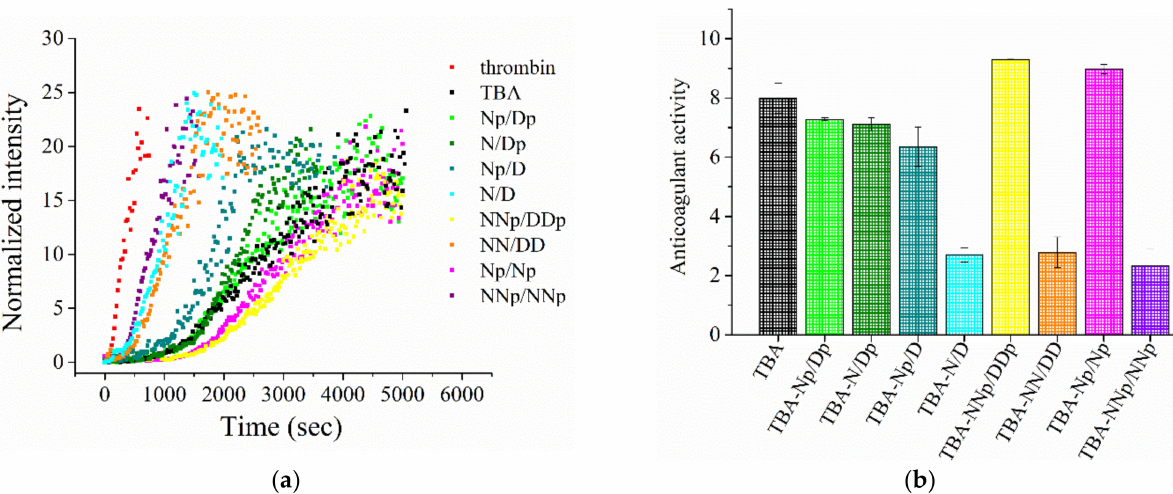
Figure 7. ( a ) Coagulation curves for the pseudo-cyclic TBAs and unmodified TBA at 1:5 thrombin:aptamer molar ratio in PBS, as determined by following the thrombin-catalyzed conversion of fibrinogen into fibrin. A curve in the absence of aptamers is also reported for comparison. ( b ) Anticoagulant activity of pseudo-cyclic TBAs and unmodified TBA. Each experiment was performed at least three times, and the mean value with the standard deviation is